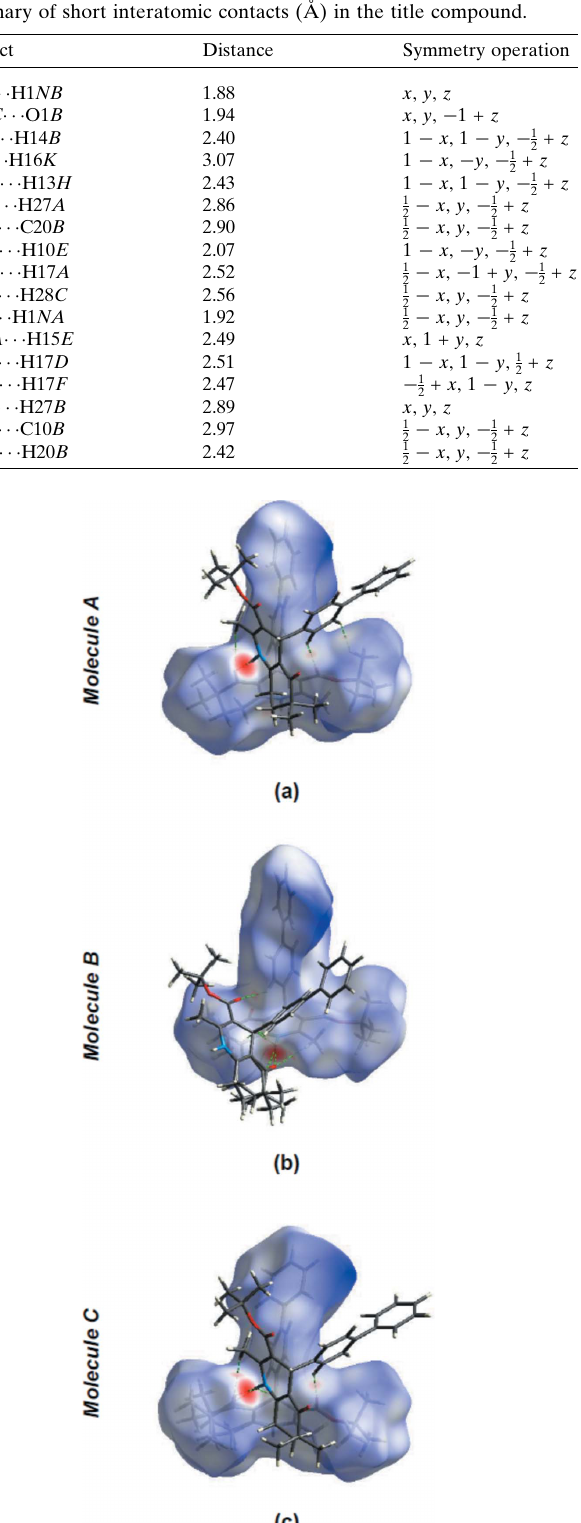
Figure 6 The two-dimensional fingerprint plots for molecules A , B and C showing ( a ) all interactions, and delineated into ( b ) H (cid:2)(cid:2)(cid:2) H, ( c ) C (cid:2)(cid:2)(cid:2) H/H (cid:2)(cid:2)(cid:2) C and ( d ) O (cid:2)(cid:2)(cid:2) H/H (cid:2)(cid:2)(cid:2) O interactions. The d i and d e values are the closest internal and external distances (in A˚ ) from given points on the Hirshfeld surface.